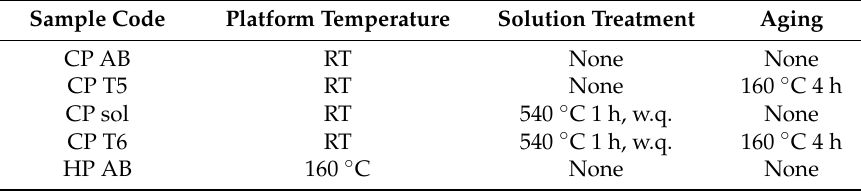
Table 2. Investigated tempers of the AlSi10Mg samples (w.q.: water